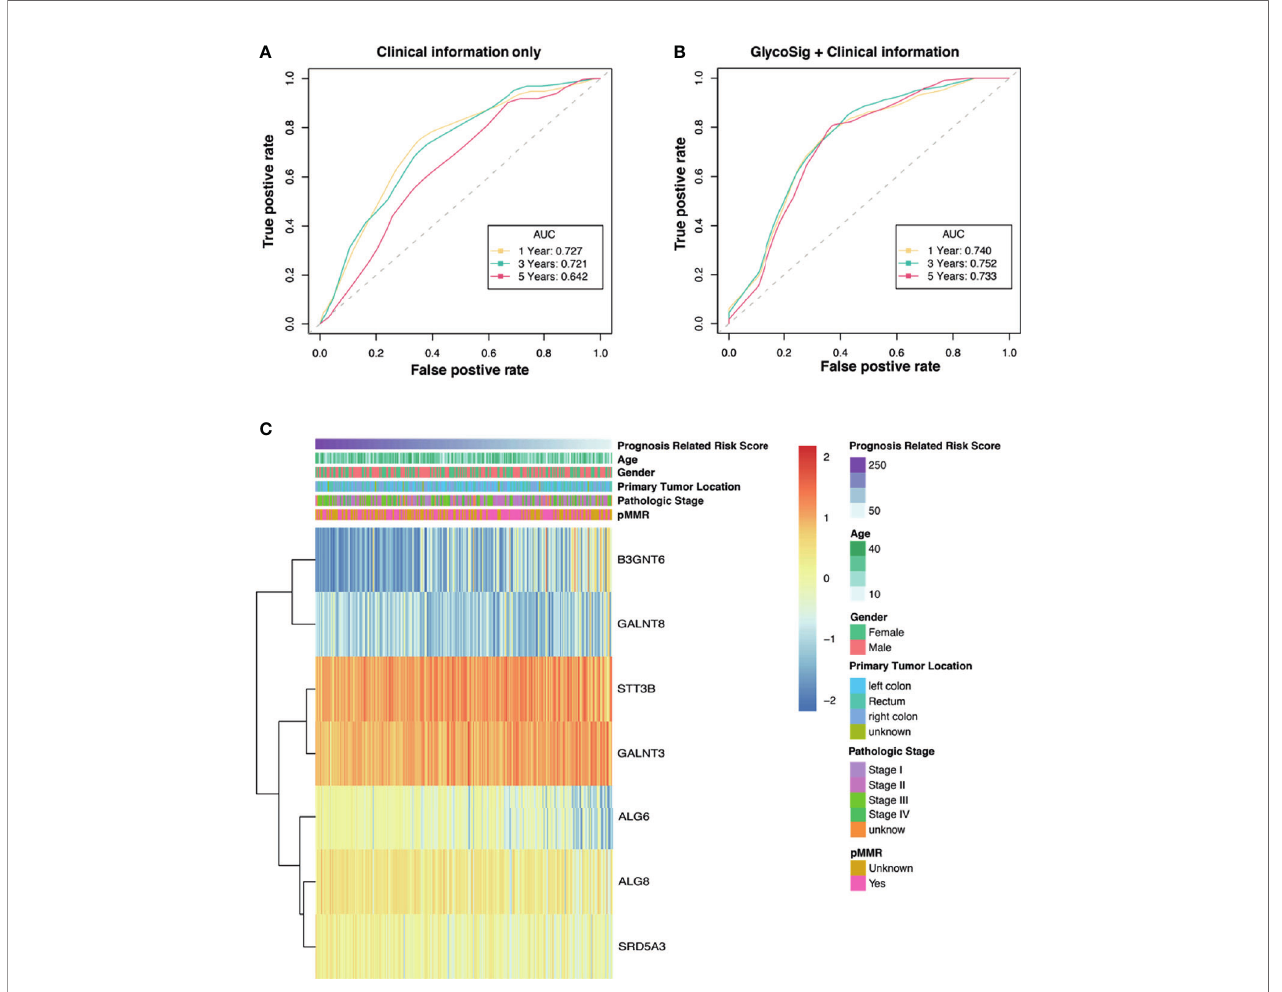
FIGURE 4 | The prognostic power of the GlycoSig biomarker set. Receiver operating characteristic (ROC) curve analysis of clinicopathologic information (A) and GlycoSig combined with clinical information (B) ; Yellow, green, and red dotted lines represent GlycoSig risk score predicting 1-, 3-, and 5-year overall survival. (C) Heatmap of the GlycoSig combined with clinical features and messenger RNA (mRNA) expression of glycogenes in The Cancer Genome Atlas (TCGA)